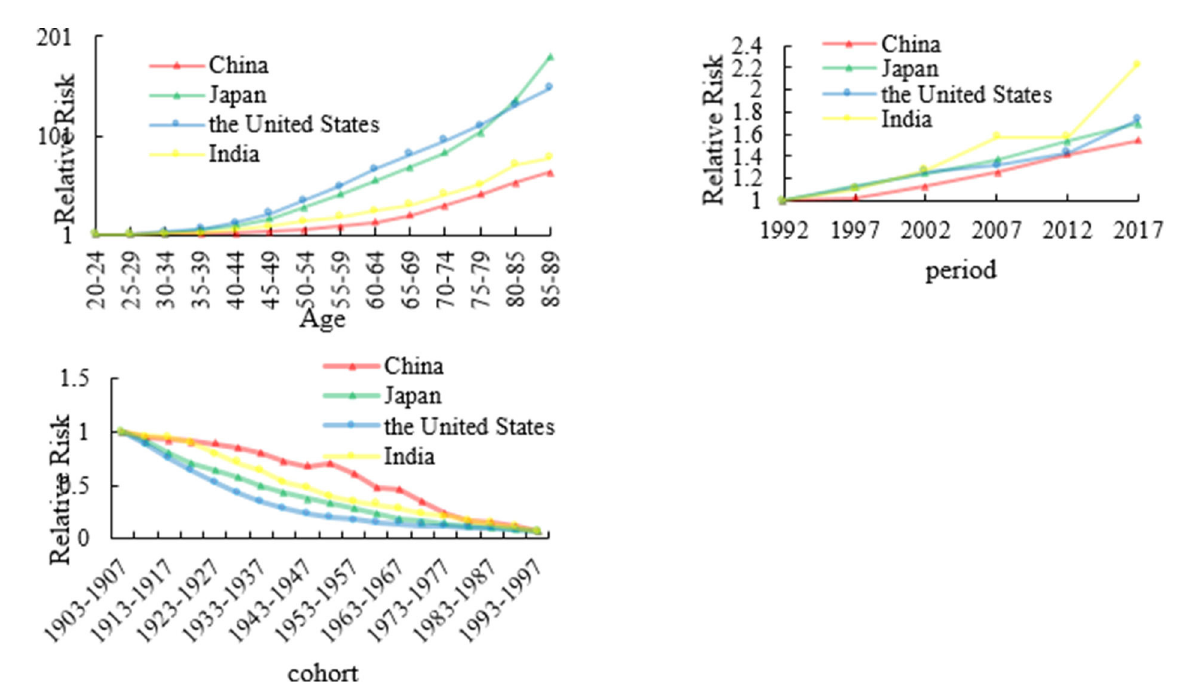
FIGURE2 The age, period, and cohort effects on colon cancer mortality across four